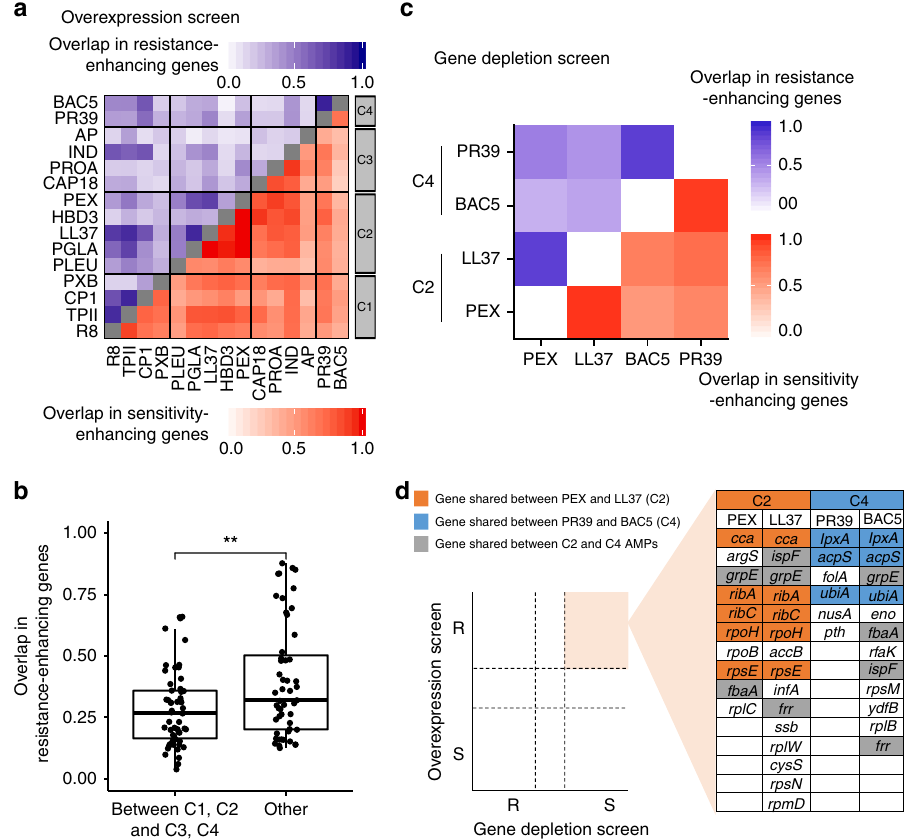
Fig. 3 Functionally diverse latent and intrinsic AMP resistomes. a Heatmap shows the corrected Jaccard similarity indices calculated for resistance- enhancing genes (blue) and sensitivity-enhancing genes (red) between AMP pairs based on the overexpression screen (see Methods for calculation of corrected Jaccard indices, n = 210, that is, the number of AMP pairs). The darker the color the higher the overlap of gene sets between AMP pairs. Source data are provided as a Source Data fi le. b The overlaps in the latent resistomes (genes enhancing resistance upon overexpression) between AMP pairs belonging to different chemical-genetic clusters. Signi fi cant difference: ** P = 0.0045 from two-tailed unpaired t -test, n = 54 and n = 51 for between C1, C2, and C3, C4, and others, respectively. Boxplots show the median (center horizontal line), the fi rst and third quartiles (bottom and top of box, respectively), with whiskers showing either the maximum (minimum) value or 1.5 times the interquartile range of the data. c Heatmap shows the corrected Jaccard similarity indices calculated for resistant (blue) and sensitive (red) chemical-genetic interactions with partially depleted essential genes (see Methods). Source data are provided as Supplementary Data 5. d Schematic fi gure showing sets of essential genes that simultaneously enhance AMP resistance when overexpressed and sensitivity when depleted. Color code is explained in the fi